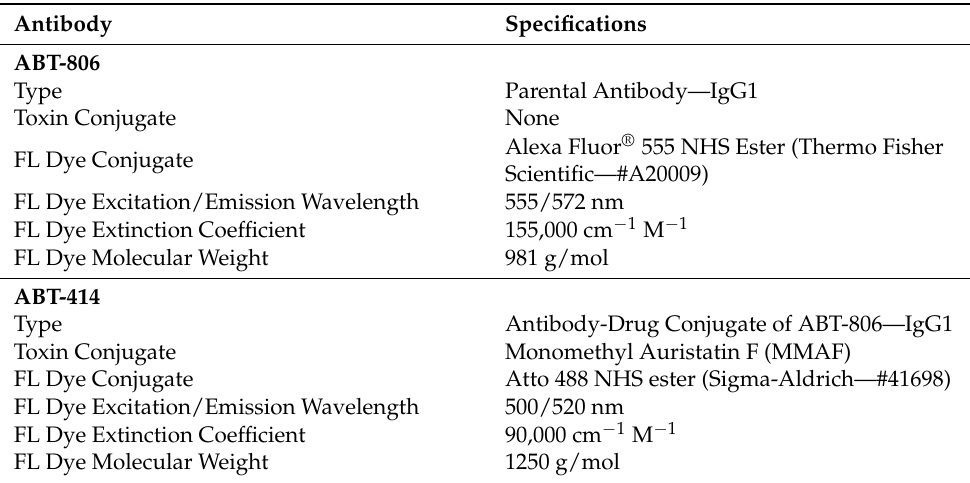
Table 1. List of fluorescently labeled antibodies administered in